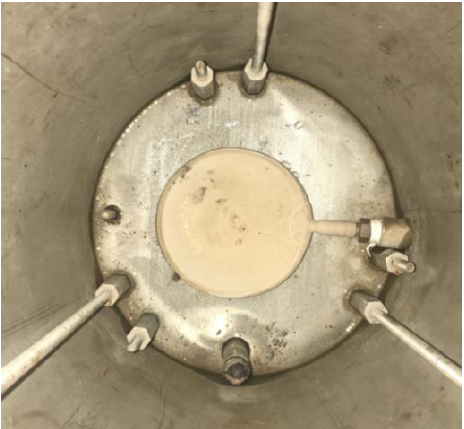
Figure 1. A bladder inside the sealed container of MIST.